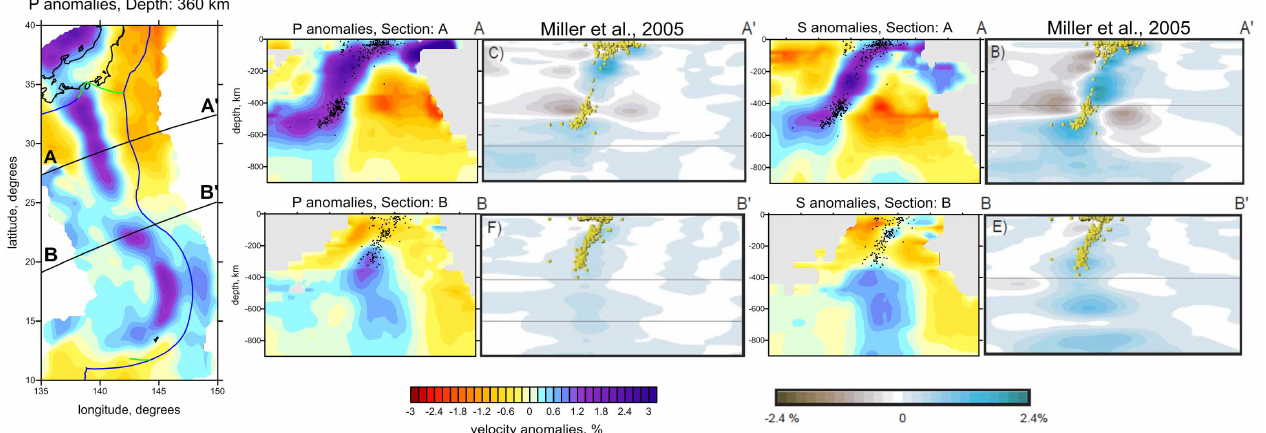
Fig. 5. Example of comparing our tomographic images with the model by Miller et al. (2005). Locations of sections are shown in the map on the left. Both P- and S-anomalies are